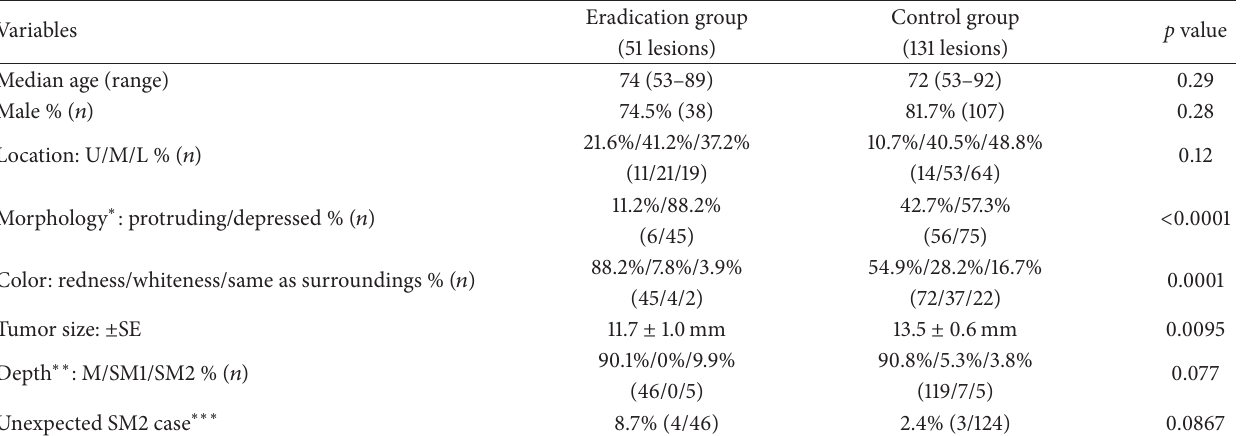
Table 1: Clinic-pathological characteristics of EGC lesions among eradication and control